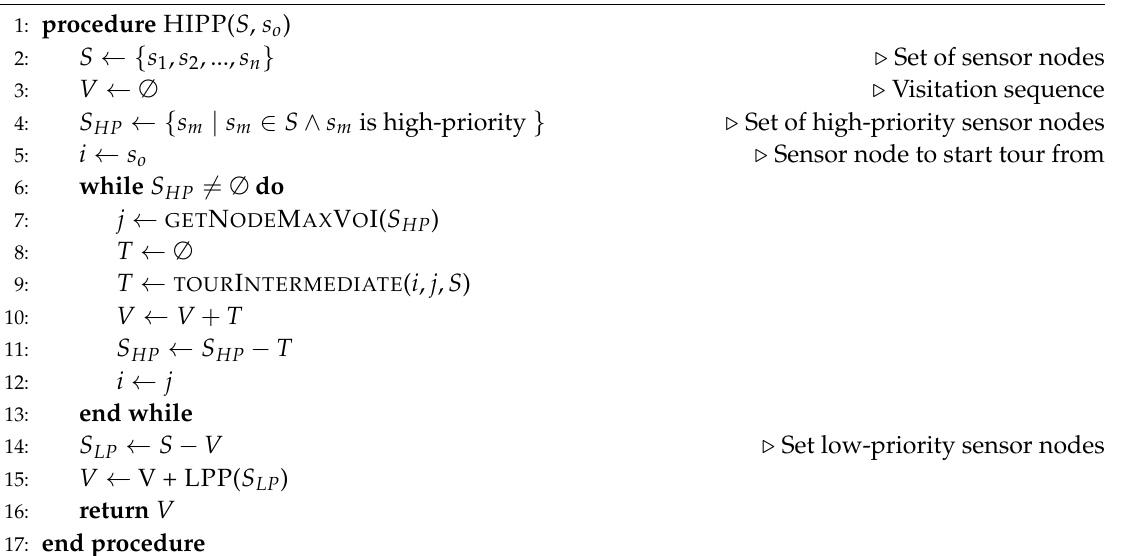
Algorithm 5 Hybrid Path Planner with Intermediate-Node-Visitation– HIPP